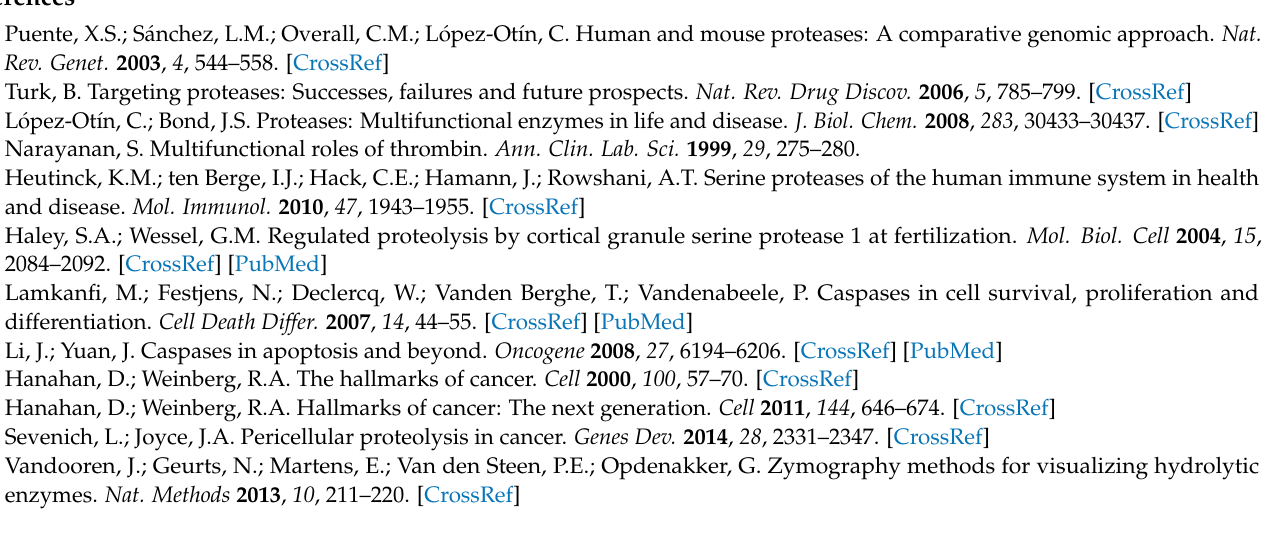
human donors, Table S2: In vitro stability of CX-188 in plasma from lung cancer patients, Table S3: In vitro stability of CX-188 in plasma from gastric cancer patients, Figure S1: Design of non-binding antibody, Figure S2: Reproducibility of the assay, Figure S3: C225-M01 and C225-S01 Pb-Tx protease selectivity, Figure S4: Substrate protease cleavability in an internally quenched (IQ) probe vs. Pb-Tx format, Figure S5: Electropherogram images of CX-188 incubated in